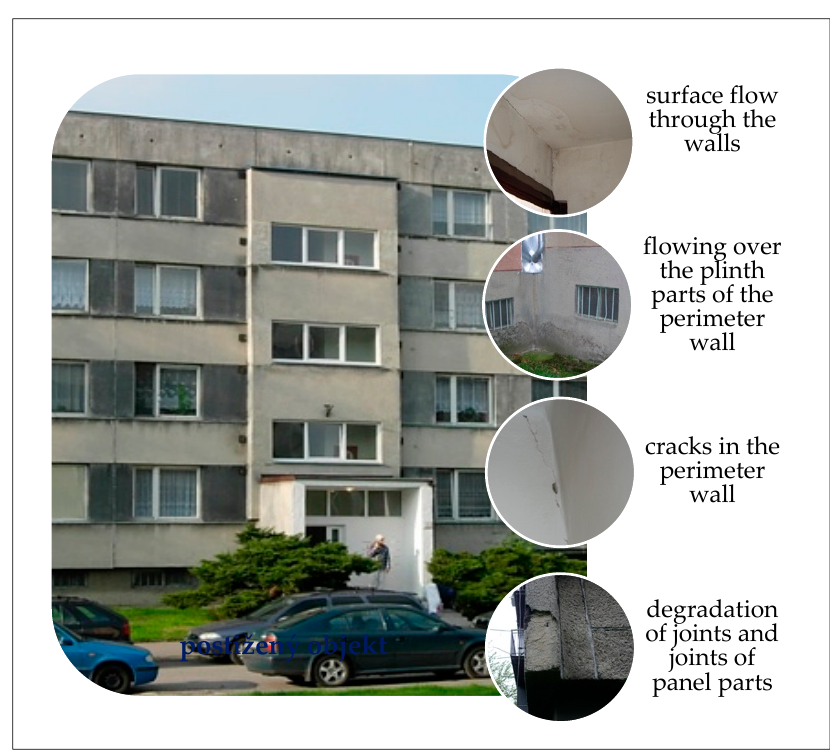
Figure 6. Condition of a prefab residential housing apartment building before the application of ETICS and defects and failures of the external wall (photo source: Author’s archive [29,30]).